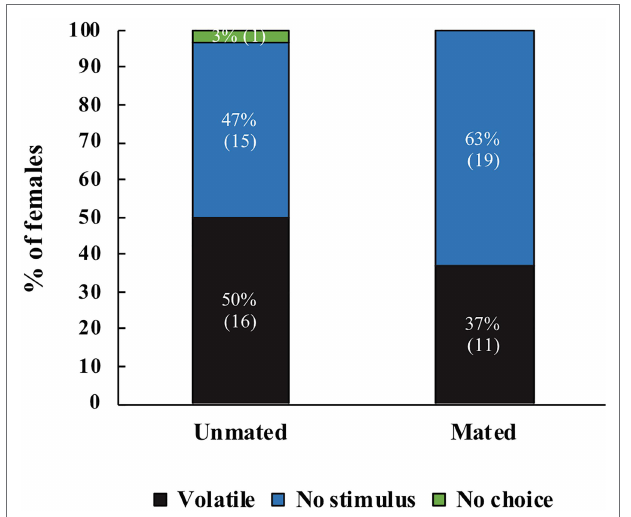
FIGURE 3 | Response of unmated or mated A. obliqua females to host volatiles or no stimulus, ( N = 32 for unmated, N = 30 for mated) There were no significant differences. Numbers within parenthesis represent sample